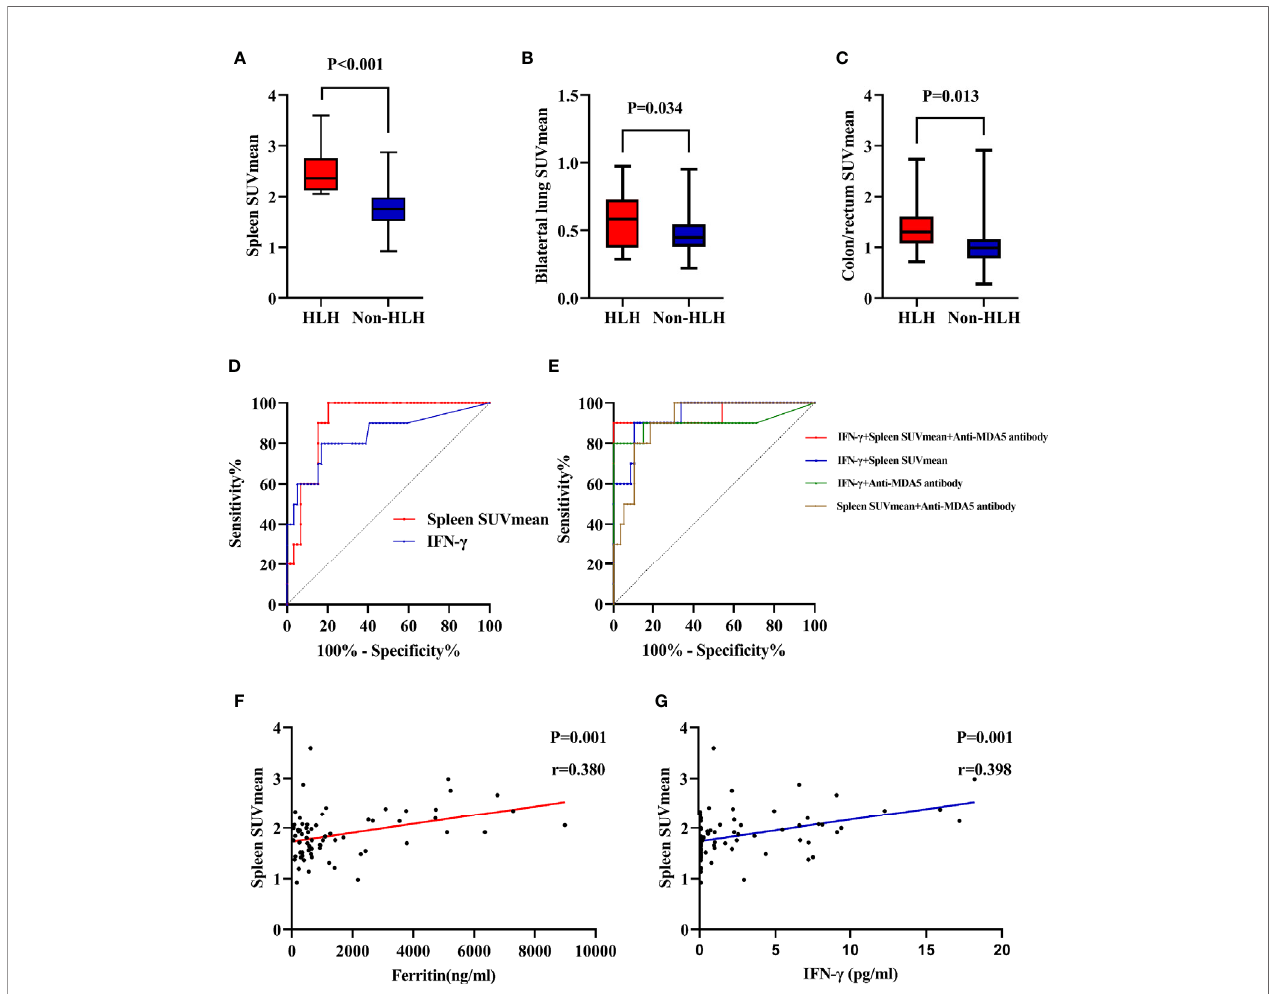
FIGURE 4 | Evaluation of 18 F-FDG uptake in IIM patients with or without sHLH. (A) Comparison of spleen SUVmean between HLH and non-HLH groups. (B) Comparison of bilateral lung SUVmean between HLH and non-HLH groups. (C) Comparison of colon/rectum SUVmean between HLH and non-HLH groups. (D) ROC curve analysis of spleen SUVmean and IFN- g in predicting sHLH. (E) ROC curve analysis of combination of two or three statistically signi fi cant parameters in predicting sHLH. (F) Correlation of spleen SUVmean and serum ferritin. (G) Correlation of spleen SUVmean and serum IFN- g . 18 F-FDG, 18 F- fl uorodeoxyglucose; IIM, Idiopathic in fl ammatory myopathy; sHLH, Secondary hemophagocytic lymphohistiocytosis; SUVmean, mean standard uptake value; ROC, Receiver operating characteristic; IFN,